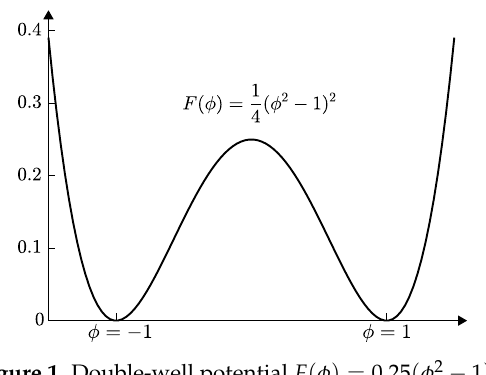
Figure 1. Double-well potential F ( φ ) = 0.25 ( φ 2